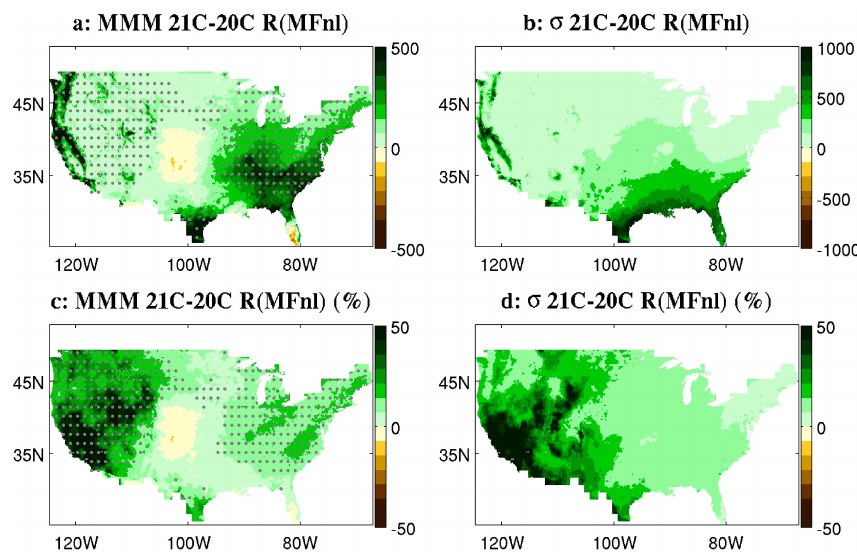
Figure 14. As in Fig. 12, but for erosivity calculated by non-linear regression from the modified Fournier index F (method